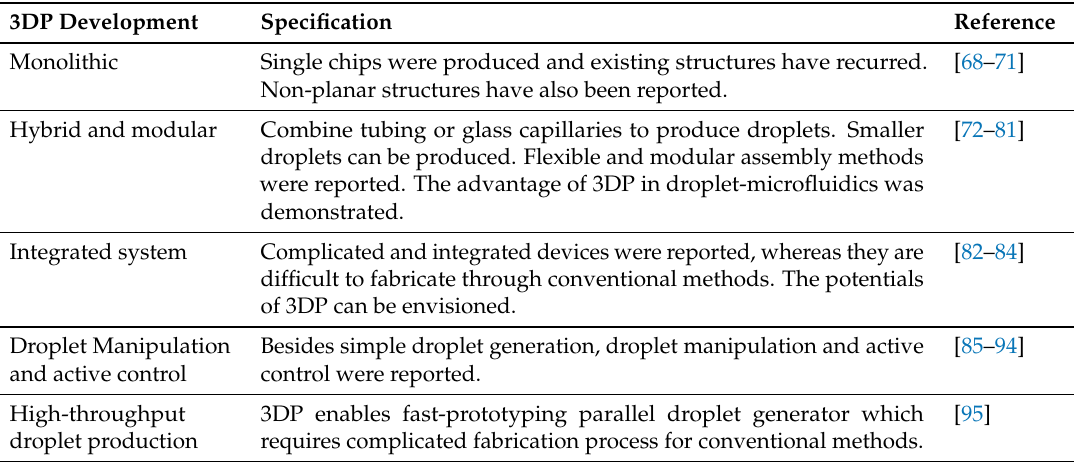
Table 1. A brief summary of recent 3DP development in